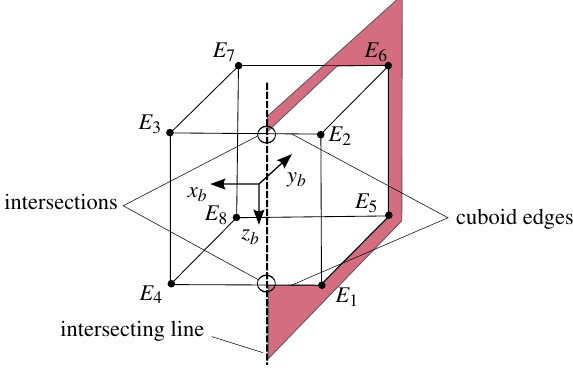
Figure 2: Calculation of intersecting points between laser scanner plane and UAV cuboid